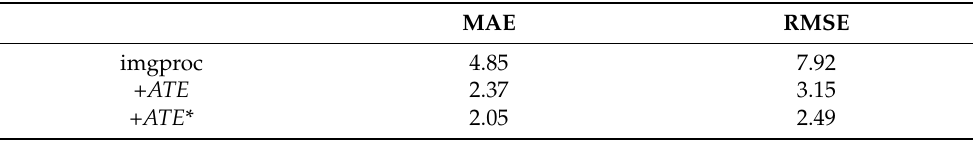
Table 5. The results of the prediction model.imgproc only uses the image classification module, + ATE combines the causal effect of environmental factors, and + ATE * adjusts the hyperparameters α and β .